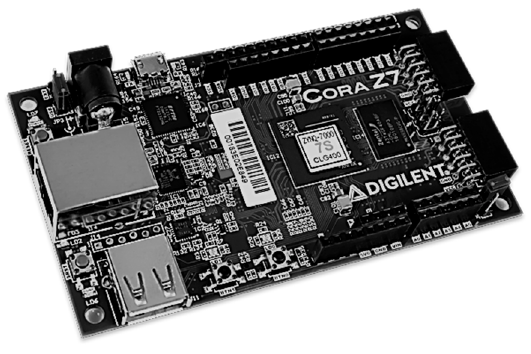
Figure 10. ZYNQ Z7-7010 Dual Core ARM-FPGA SoC.